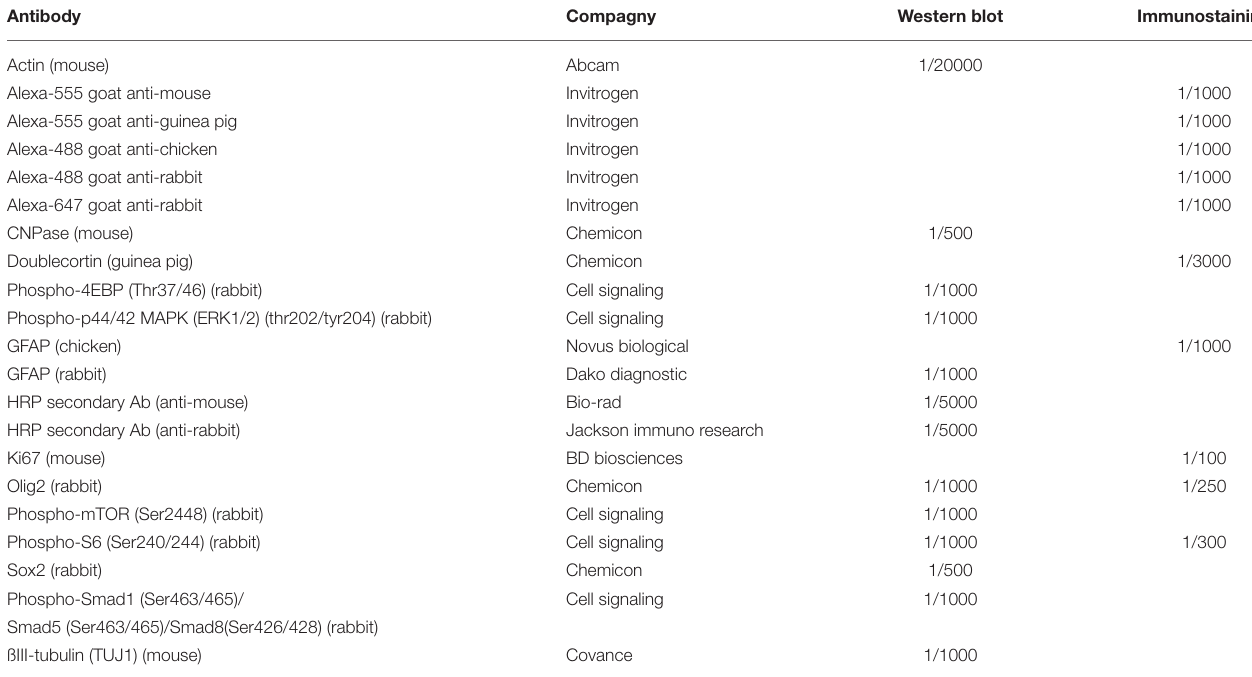
TABLE 1 | Antibody